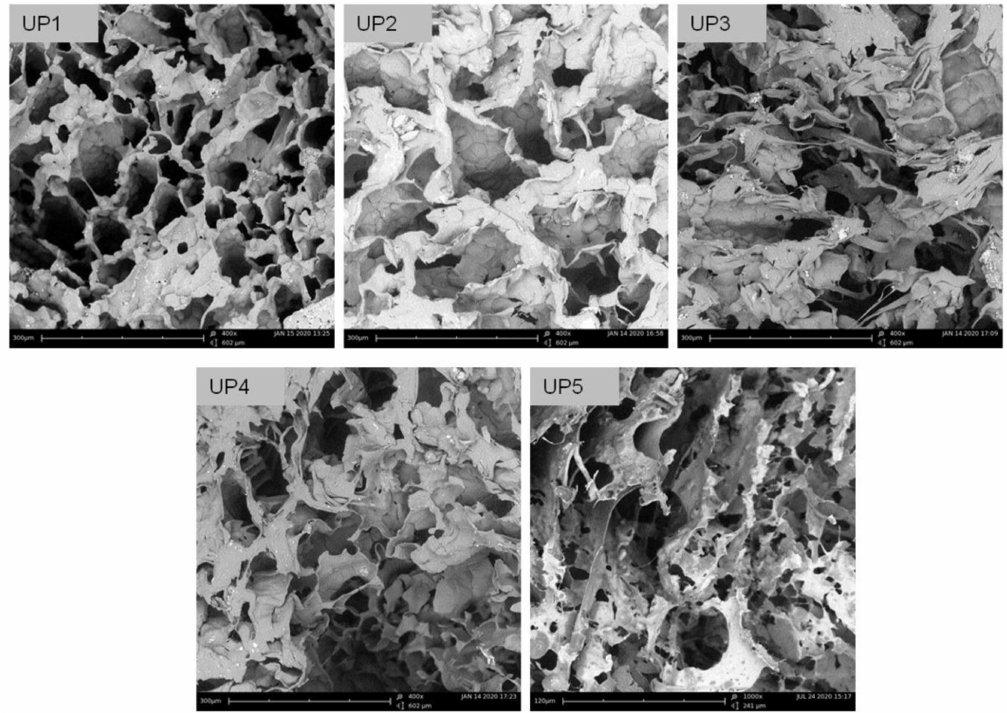
Figure 2. SEM images of the UP